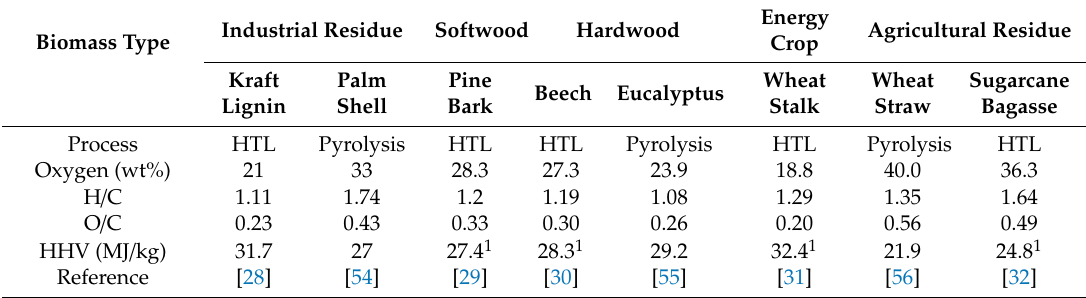
Table 4. Properties of HTL bio-oils for di ff erent biomass feedstocks. Oxygen (O), H / C, O / C, ash, and higher heating value (HHV) on a water-free